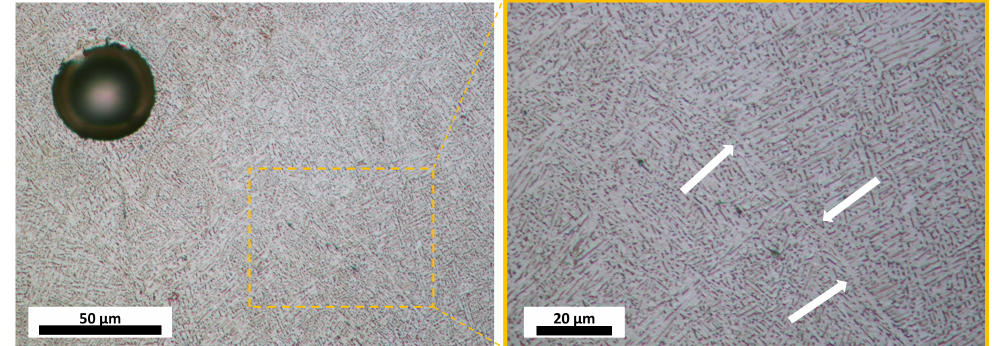
Figure 2. Typical microstructure in the observed material. A medium sized pore is visible. White ar- rows highlights an example of grain boundary α . Images are taken in the plane perpendicular to the building direction.